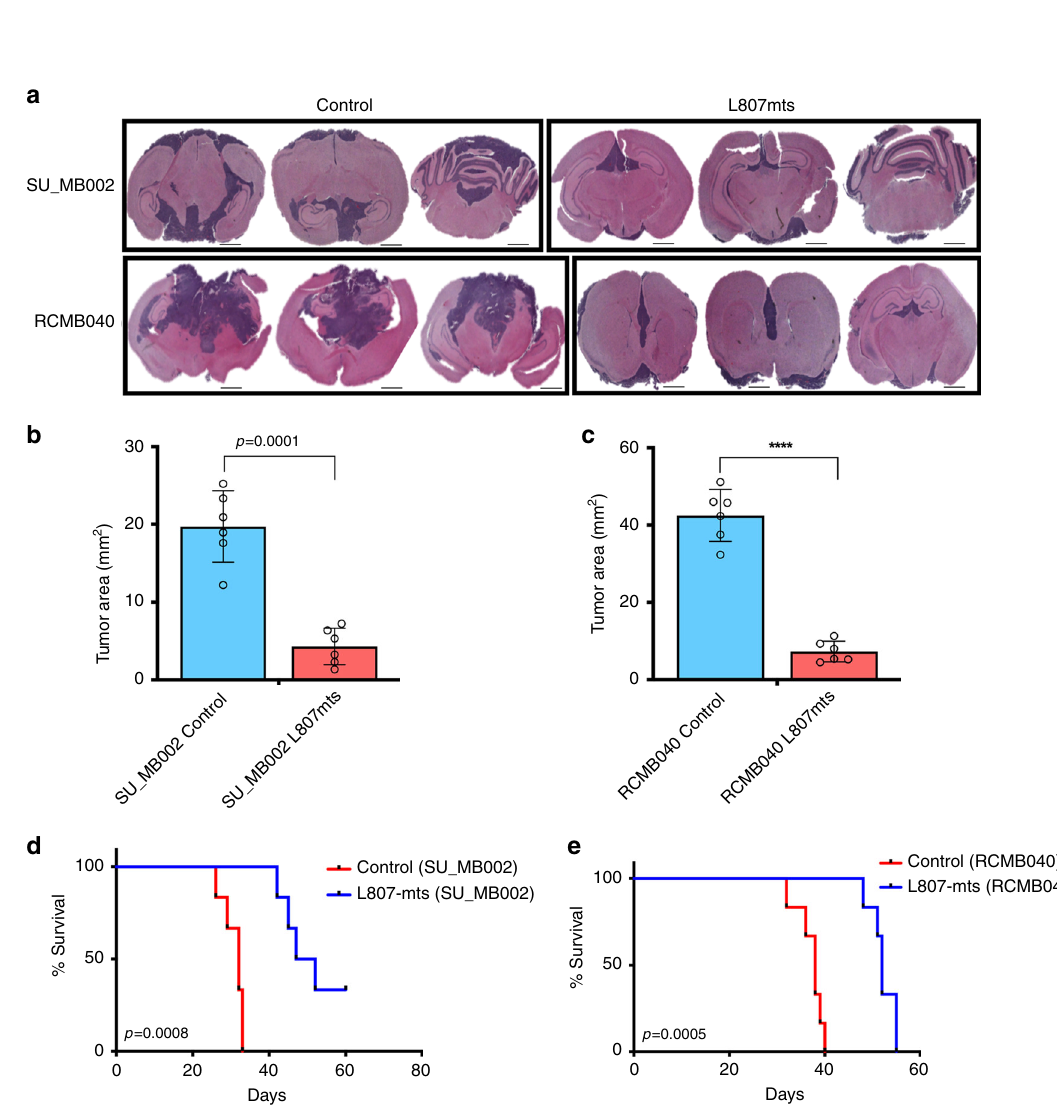
Fig. 5 Pharmacological activation of Wnt signaling in MB reduces tumor formation and improves overall survival. a Representative histology images of xenografts generated from patient-derived treatment-refractory MBs following L807mts treatment ( n = 6 per MB line) contain a reduction in overall tumor burden when compared with xenografts treated with PBS control ( n = 6 per MB line). b SU_MB002 ( n = 12, p = 0.0001) c RCMB40 ( n = 12, p = 0.000011), treated with L807mts ( n = 6, individual mice per MB line) contain a signi fi cant reduction in overall tumor volume when compared with PBS control-treated xenografts ( n = 6, individual mice per MB line). Xenografts of d SU_MB002 ( n = 12; median survival L807mts 49.5 days, PBS 32.0 days; p = 0.0008, n = 12), and e RCMB40 ( n = 12; median survival L807mts 52.9 days, PBS 38.0 days; p = 0.0005) treated with L807mts display a signi fi cant survival advantage when compared with control PBS-treated mice. Histology image scale bar = 5000 μ m. Panels ( b , c ) contain error bars expressed as mean ± standard error (mean) using two-tailed, unpaired Student ’ s t test. Panels ( d , e ) analyzed using log-rank (Mantel – Cox) test. **** p <